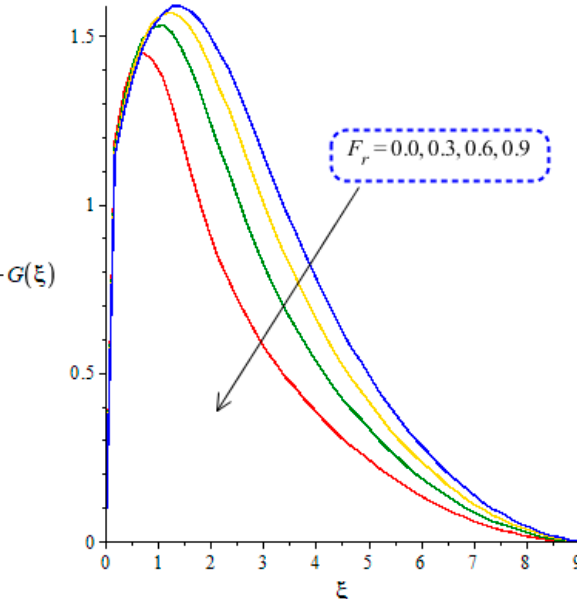
Figure 5. Variation role of − G ( ξ ) versus F r when m = 0.4, We = 5, Ω = 2.0, M 2 = 0.1, β e = 0.5, Figure 5. Variation role of −𝐺(𝜉) versus 𝐹 (cid:3045) when 𝑚 = 0.4, 𝑊𝑒 = 5, Ω = 2.0, 𝑀 (cid:2870) = 0.1,𝛽 (cid:3032) = β i = 0.3, (cid:101) = 0.01, Pr = 204, Ec = 0.4, ϕ 2 = 0.0075, ϕ 1 = 0.002, ϕ 3 =